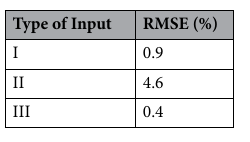
Table 2. RMSE for sample input functions.